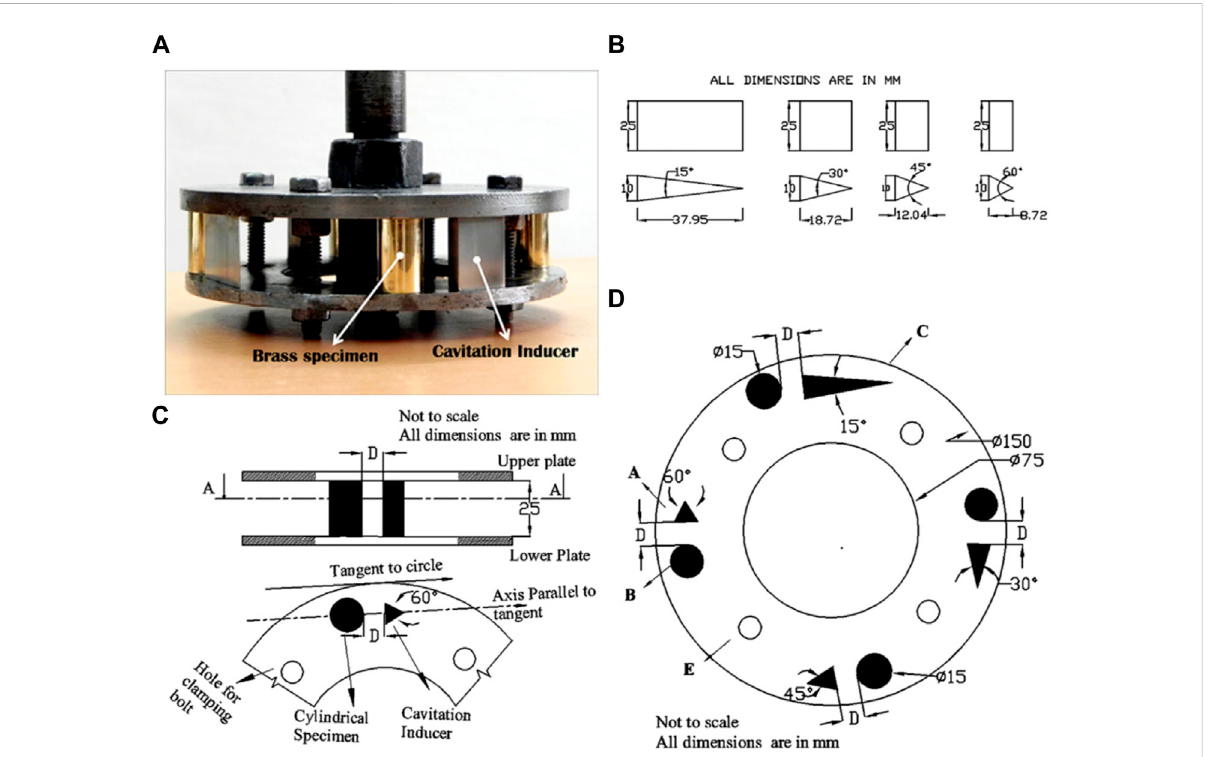
FIGURE 5 Slurrypottest(Amarendraetal.,2012). (A) Photographofthespecimenholderofthemodi fi edslurrypottestsetup; (B) drawingofthecavitation inducers; (C) schematic diagram of the specimen holder with section at A-A; (D) positioning of the CIs and the specimen. A — CI, B — cylindrical specimen, C — lower base plate, D — distance between specimen and cavitation inducer and E — hole for clamping the bolt.